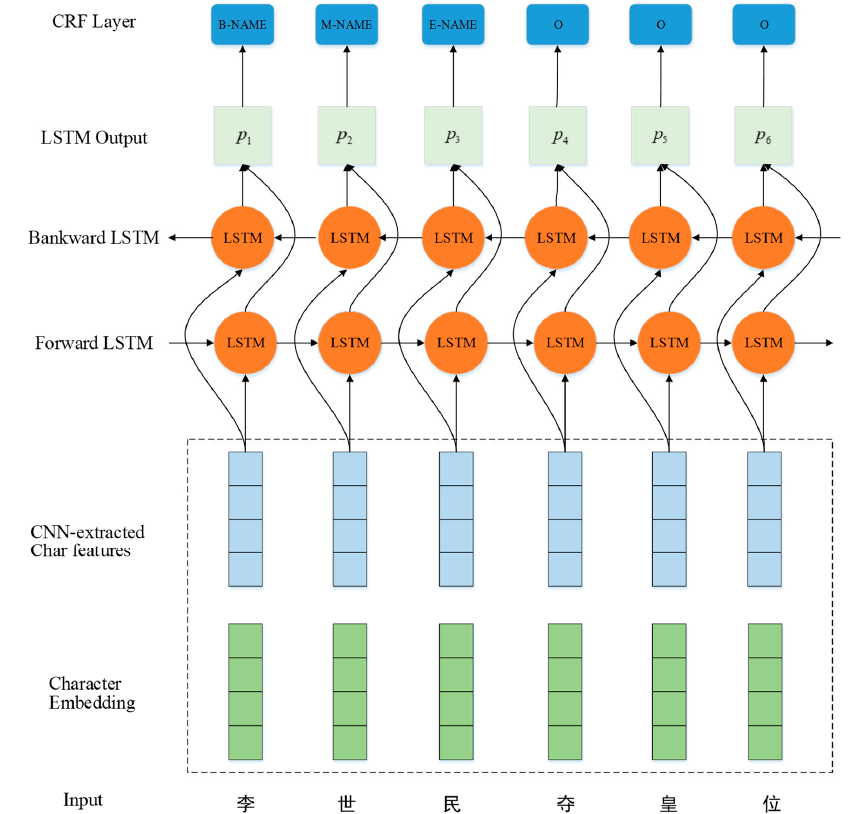
Figure 5. Bidirectional short-term memory-Convolutional Neural Networks-Conditional Random Field (BiLSTM-CNN-CRF) model of named entity recognition of Chinese ancient historical and cultural knowledge graph. The overall structure of the model is divided into three levels: (1) comprehensive embedding, including character embedding and word embedding. (2) Bidirectional short-term memory (BiLSTM) layer. This layer is used to capture historical and future information in the sentence of this article. (3) Conditional Random Field (CRF) layer. This layer is labeled with CRF. B in B-NAME indicates the beginning, NAME indicates the name of the person, M in M-NAME indicates the middle, NAME indicates the name of the person, E in E-NAME indicates the end, and NAME indicates the name of the person. The Chinese input is “ 李 世 民 夺 皇 位 ” (means: Li Shimin seizes the throne), where Li Shimin is a person’s name.